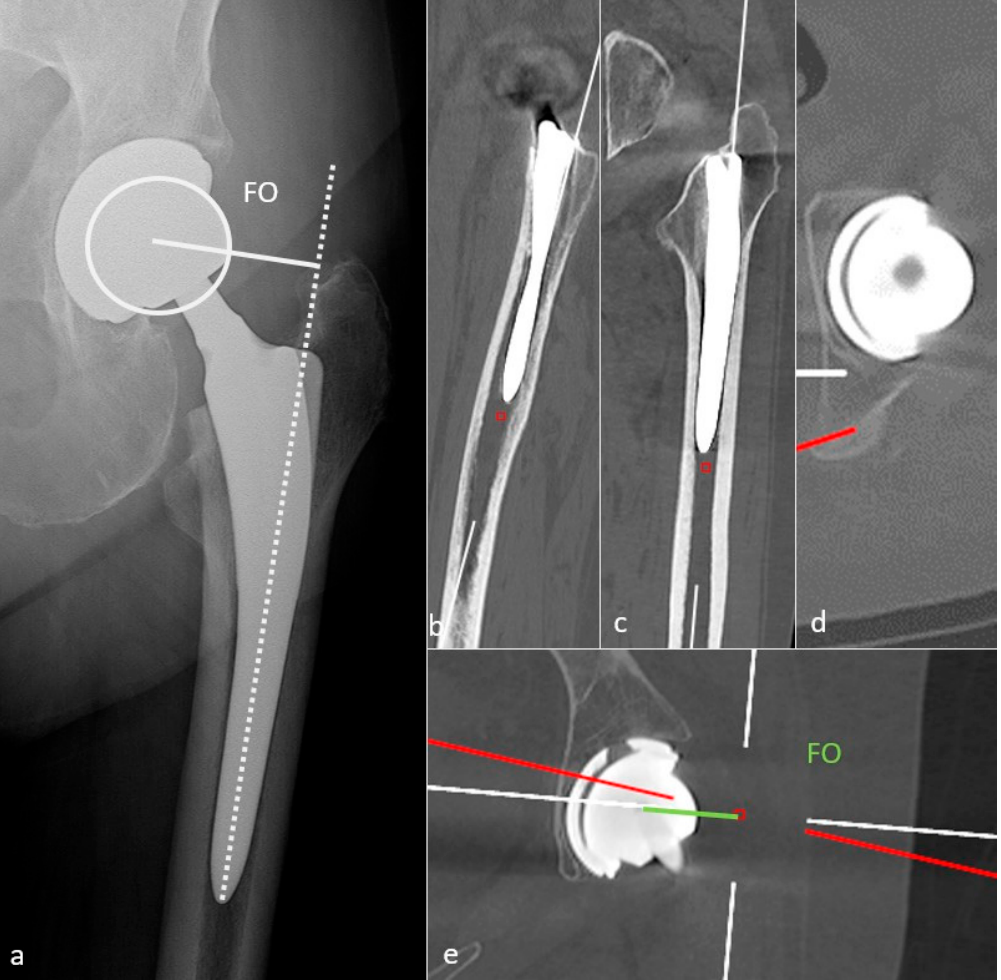
Figure 9. Femoral offset (FO). The radiographic method is shown on ( a ) an anteroposterior hip view and corresponds to the perpendicular distance (white line) between the femoral head (white circle) and the femoral axis (dotted white line). A CT method is also proposed. First, on ( b ), in the sagittal plane, the femoral inclination is considered, then on ( c ) in the frontal plane, and the level of the center of the femoral head is repaired in ( d ). Finally, in ( e ), the FO can be measured (green line) as the perpendicular distance between the resulting femoral axis (white vertical line) and the center of the femoral head.